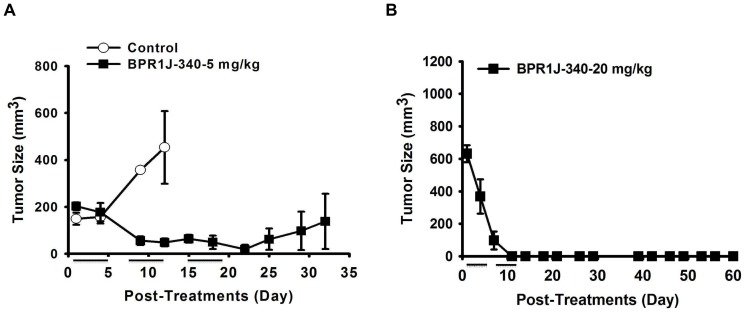
Antitumor activity of BPR1J-340 against FLT3-ITD-driven leukemia tumor growth in nude mice.BPR1J-340 (i.v.) is active against human acute leukemia MOLM-13 tumors growing subcutaneously and can reduce the size of tumors even after the tumors were allowed to grow to a size of >630 mm3. (A) The in vivo antitumor effect of BPR1J-340 in the MOLM-13 xenograft nude mice model. The growth of the tumor xenograft was inhibited by BPR1J-340 [5 mg/kg, i.v.]; p<0.05 compared with vehicle treatment. (B) The subcutaneously growth of a MOLM-13 tumor of large size (>630 mm3) in nude mice could be significantly reversed by BPR1J-340 [20 mg/kg, i.v.].